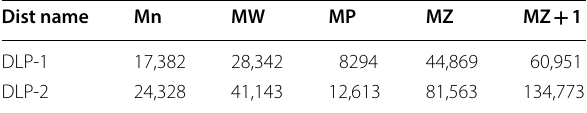
Table 1 GPC analysis of DLP-1 and DLP-2